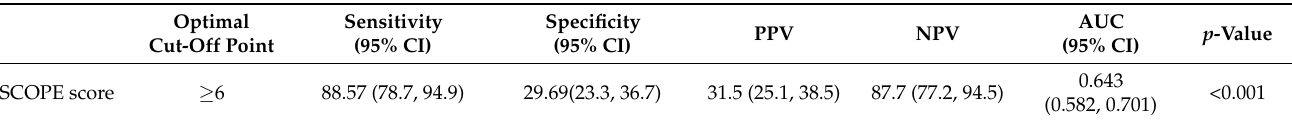
Figure 4. ROC Curve for the use of SCOPE as a predictor of mortality in patients hospitalized in the ICU for severe COVID-19.